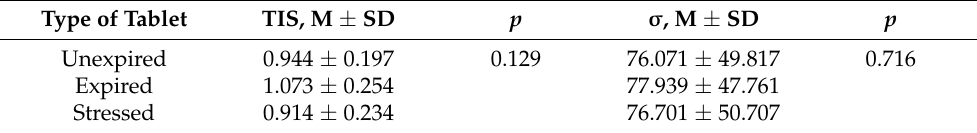
Table 2. Mean TIS values as well as mean squared deviation of the height of the roughness (σ) values for all analyzed tablets.